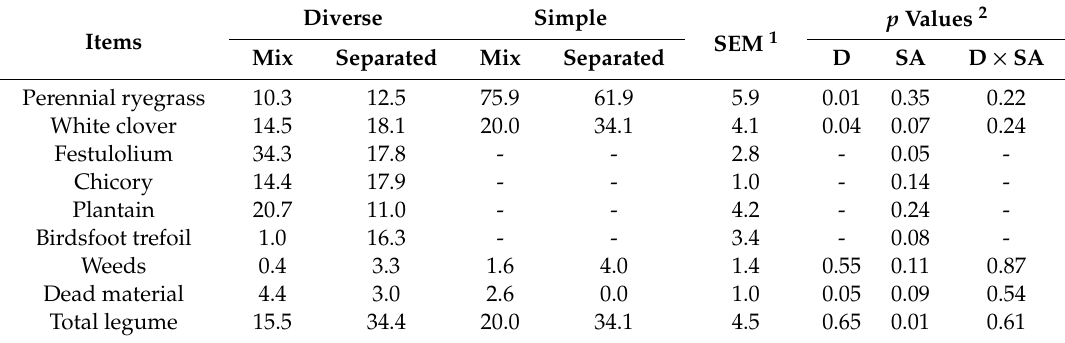
Table 4. E ff ect of pasture diversity (diverse or simple) and spatial arrangement (mix or separated) on botanical composition (% of total dry matter (DM)) of